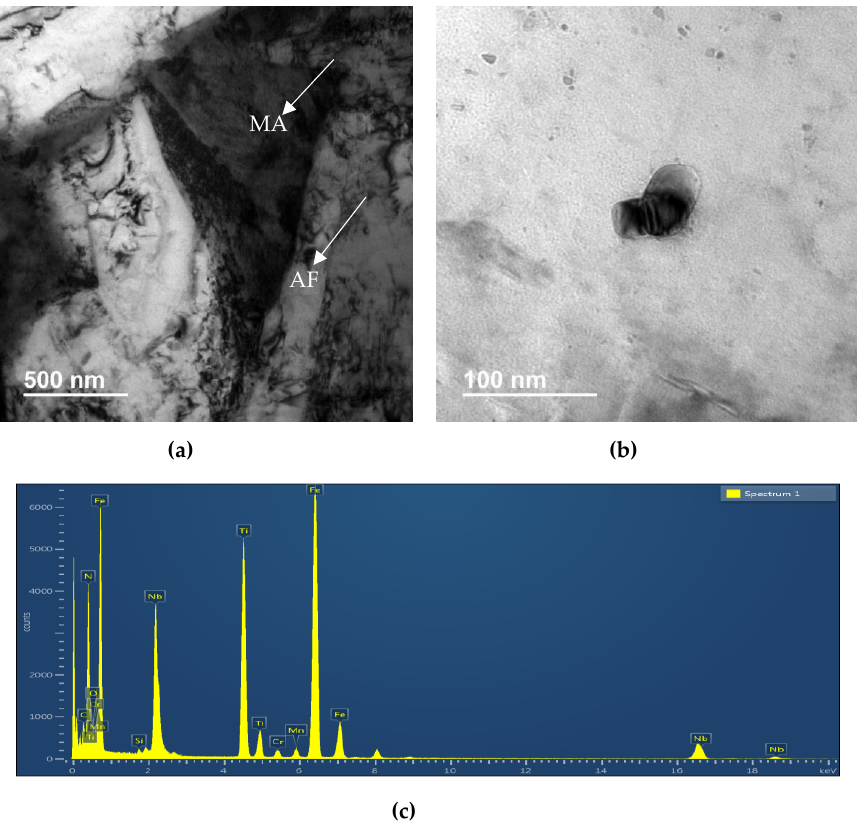
Figure 8. ( a ) Bright field image of H4 showing ferrite and carbon-enriched constituents. ( b ) Titanium-rich precipitate and the corresponding ( c ) EDS spectrum of the